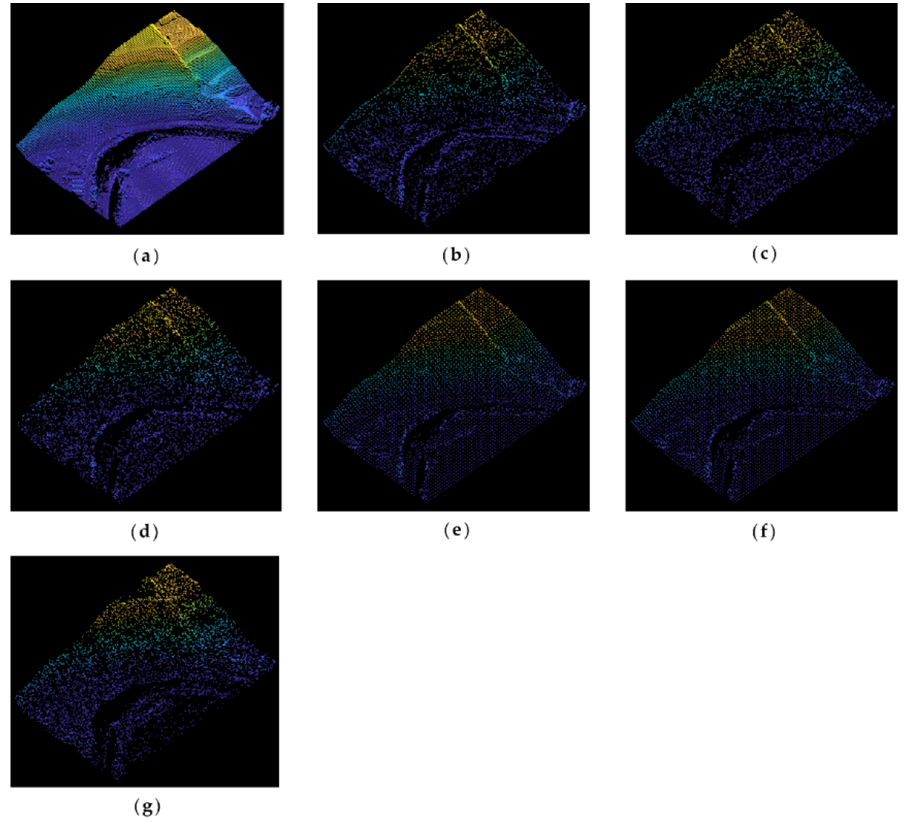
Figure 8. Original and simplified point clouds of Samp52: ( a ) original point cloud; ( b ) MIWSA; ( c ) random algorithm; ( d ) normal algorithm; ( e ) voxel algorithm; ( f ) k-means algorithm; ( g ) curvature